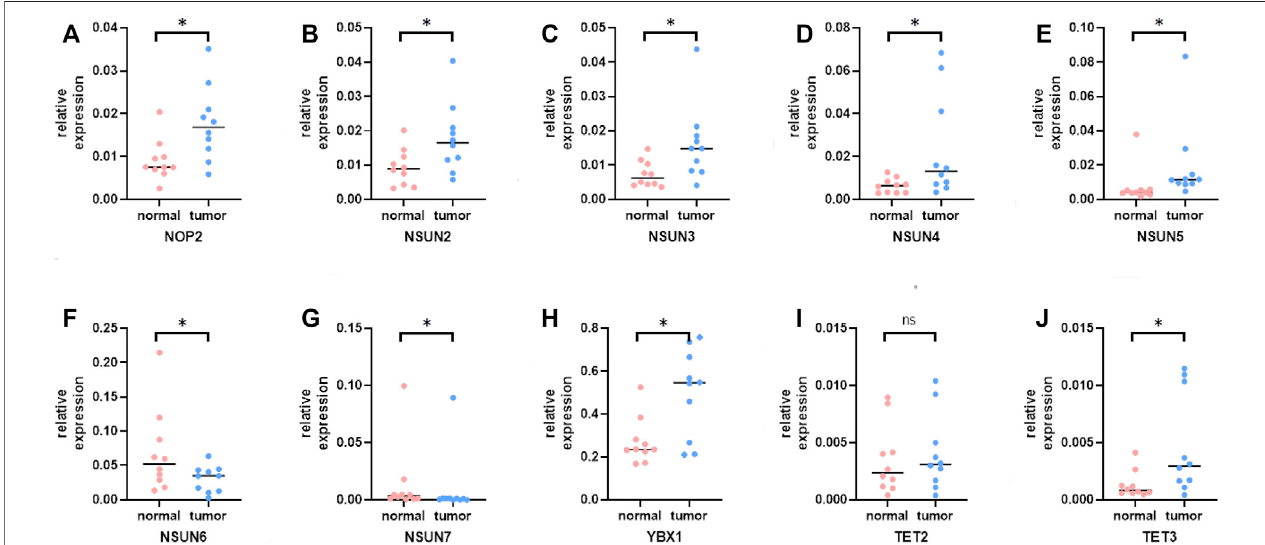
FIGURE10 | ThemRNA expression ofm5C regulators in HCC and normal tissues. (A) The mRNAexpression ofNOP2 in HCC and normal tissues; (B) The mRNA expression of NSUN2 in HCC and normal tissues; (C) The mRNA expression of NSUN3 in HCC and normal tissues; (D) The mRNA expression of NSUN4 in HCC and normal tissues; (E) The mRNA expression of NSUN5 in HCC and normal tissues; (F) The mRNA expression of NSUN6 in HCC and normal tissues; (G) The mRNA expression of NSUN7 in HCC and normal tissues; (H) The mRNA expression of YBX1 in HCC and normal tissues; (I) The mRNA expression of TET2 in HCC and normal tissues; (J) The mRNA expression of TET3 in HCC and normal